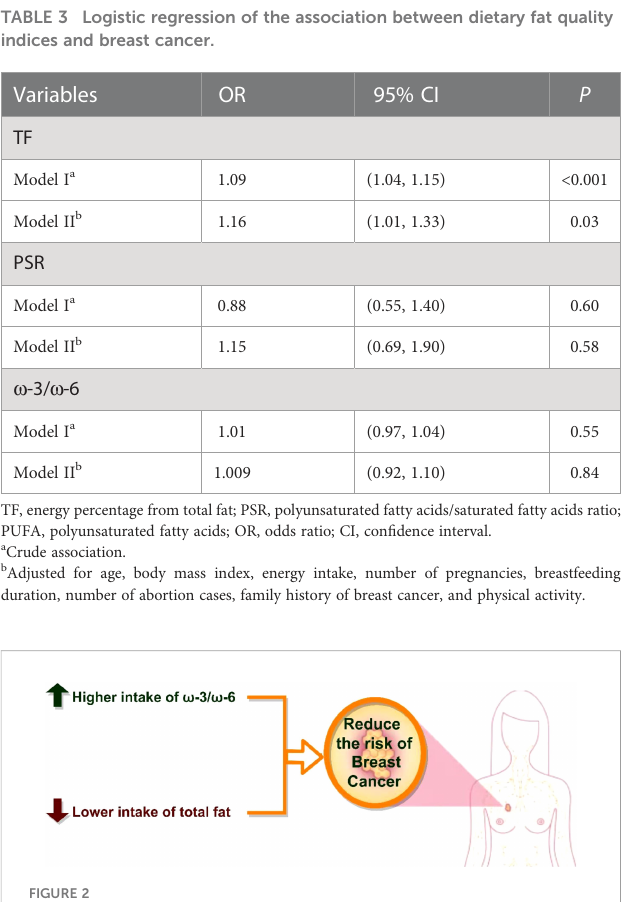
FIGURE 2 The association between breast cancer and dietary